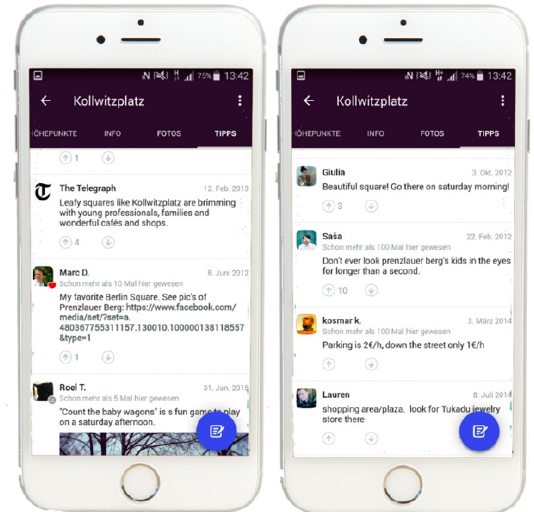
Figure 3. Berlin’s Kollwitzplatz through the lens of Foursquare City Guide. Note: screenshots captured during our case